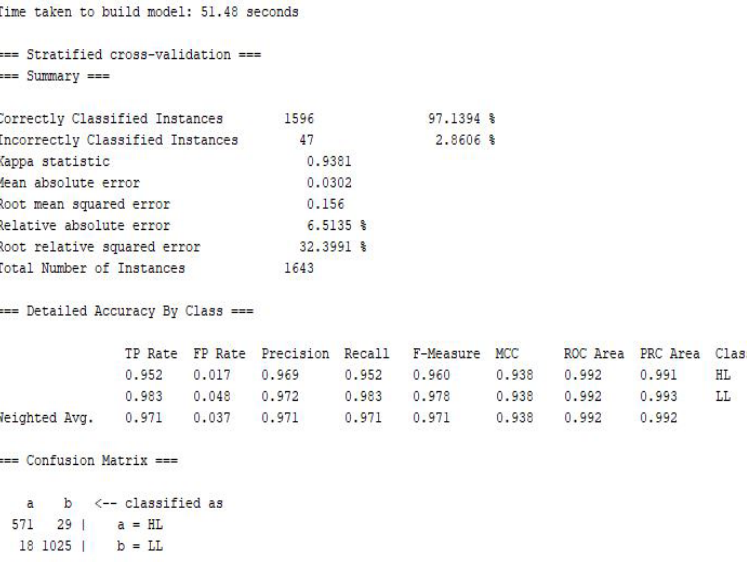
Figure 4: Multilayer perceptron (MLP) model for training